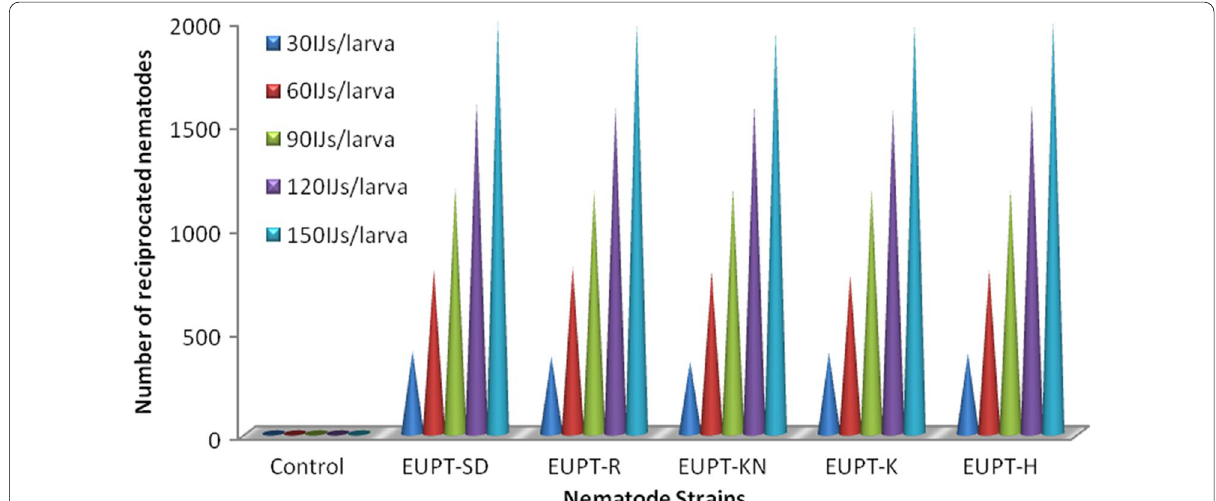
Fig. 3 Multiplication of nematode juveniles on 3rd instar larvae of Spodoptera litura after treatment with different concentrations of nematodes strains collected from various localities of Himachal Pradesh